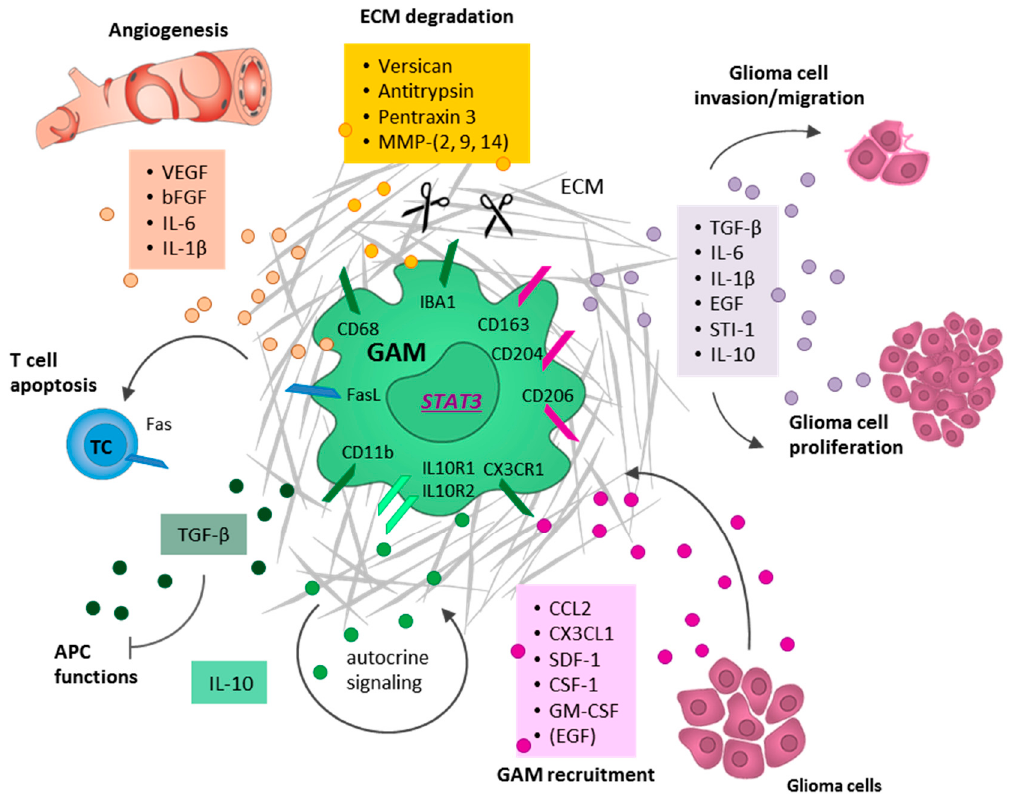
Figure 2. Contribution of glioma-associated microglia/macrophages (GAMs) to a pro-tumorigenic tumor microenvironment (TME). Glioma-associated microglia/macrophages (GAMs) are recruited to the tumor lesion by several glioma cell-derived factors (pink: CCL2, CX3CL1, SDF-1, CSF-1, GM-CSF, GDNF, EGF), resulting in a polarization towards an anti-inflammatory and pro-tumorigenic M2-like phenotype. In the presence of glioma cells, GAMs express the IL-10 receptor and the cytokine itself. Therefore, the pro-tumorigenic M2-like phenotype can be sustained by autocrine IL-10 signaling. To study M2-like polarized GAMs, a combination of microglia/macrophage markers in general (green: CD11b, CD68, IBA1, and CX3CR1) and more M2-like specific markers (pink: CD163, CD204, CD206, and STAT3) are employed. Moreover, GAMs are endowed with a M2-associated secretome facilitating extracellular matrix (ECM) degradation (yellow: versican, antitrypsin, pentraxin 3, and several matrix metalloproteinases (MMPs)), and angiogenesis (red: VEGF, bFGF, IL-6, and IL-1 β ). Through the secretion of TGF- β , IL-6, IL-1 β , EGF, STI-1, and IL-10 (violet), GAMs actively promote glioma cell proliferation, facilitate their invasion and migration, and impair immune cell functions.